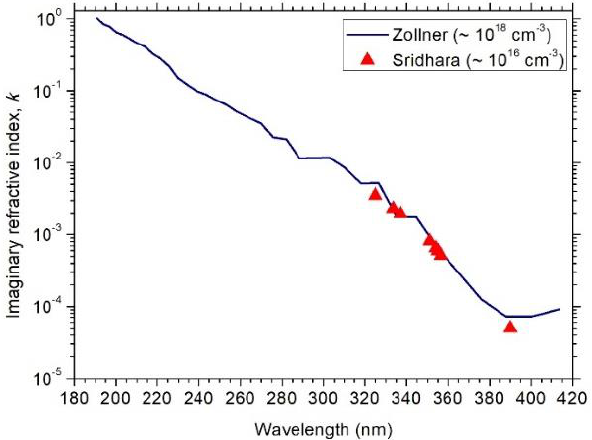
Figure 4. 4H − SiC imaginary refractive index (k) vs. wavelength.